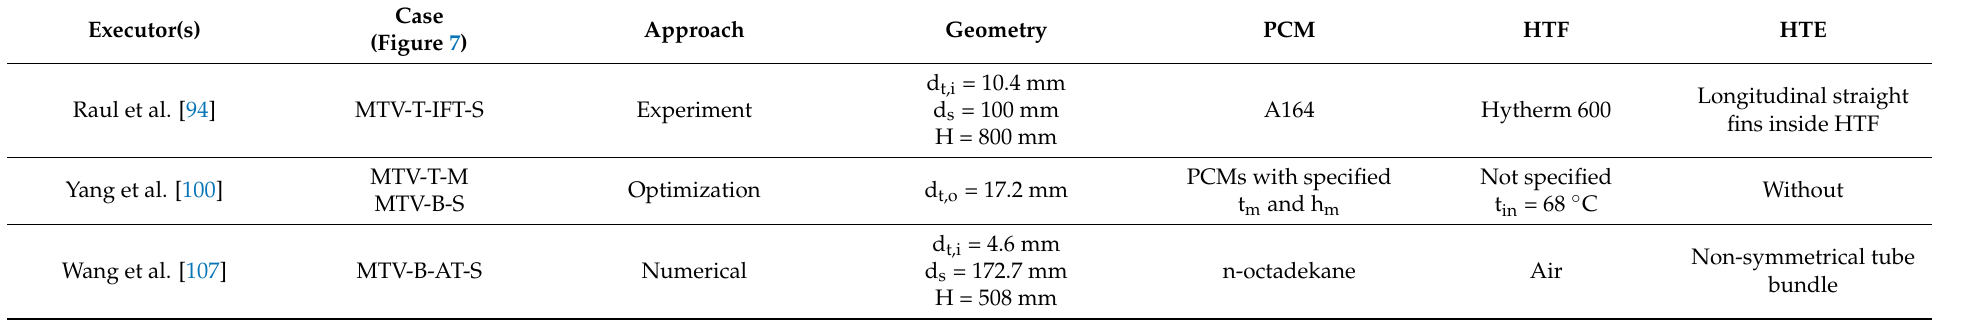
Table 7. Studies dealing with vertical multi-tube